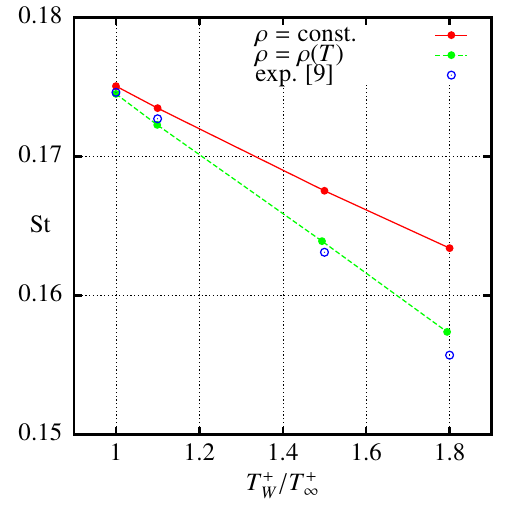
Fig. 4. Comparison of model with ρ = const . ([6]) and the current one with ρ = ρ ( T ). The di ff erence in dimensionless fre- quency of vortex shedding, St, is substantial. Computations fol- lowed Re from experiment, all being close to an average value Re ≈ 121 . 4.